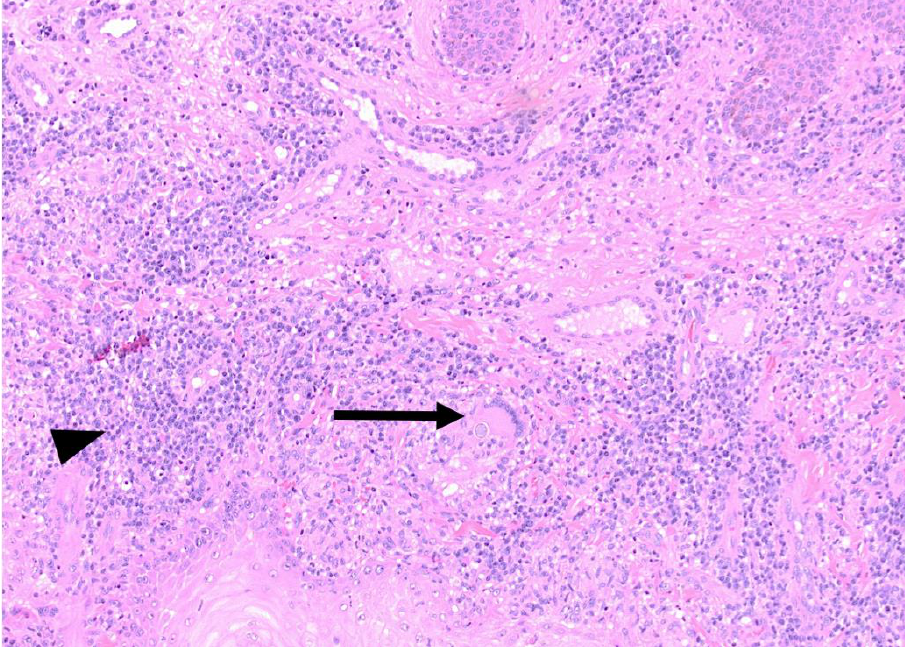
Figure 5. Photomicrograph of the biopsy specimen from the verrucous lesion on the right arm showing granulomatous inflammation (arrowhead) and multinucleated giant cell with internalized Coccidioides spherule (black arrow) (H&E), 100×.